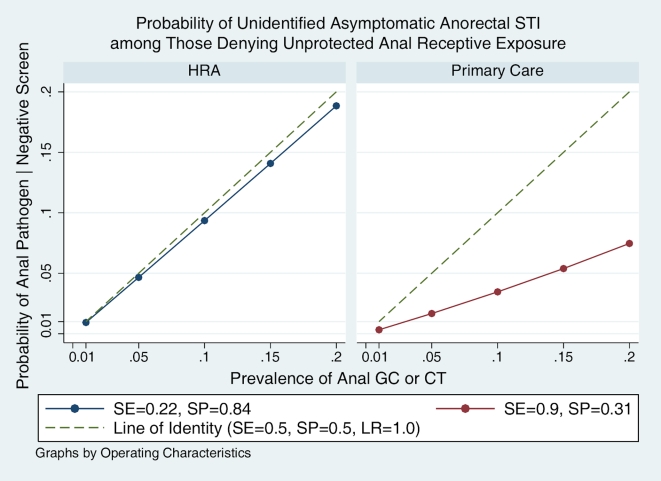
Sensitivity analysis of the probability of unidentified asymptomatic anorectal STI among those denying unprotected anal receptive exposure.X-axis displays prevalence of asymptomatic STI (C. trachomatis and/or N. gonorrhoeae infection). Y-axis shows the probability defined as one minus negative predictive value of the screening question.